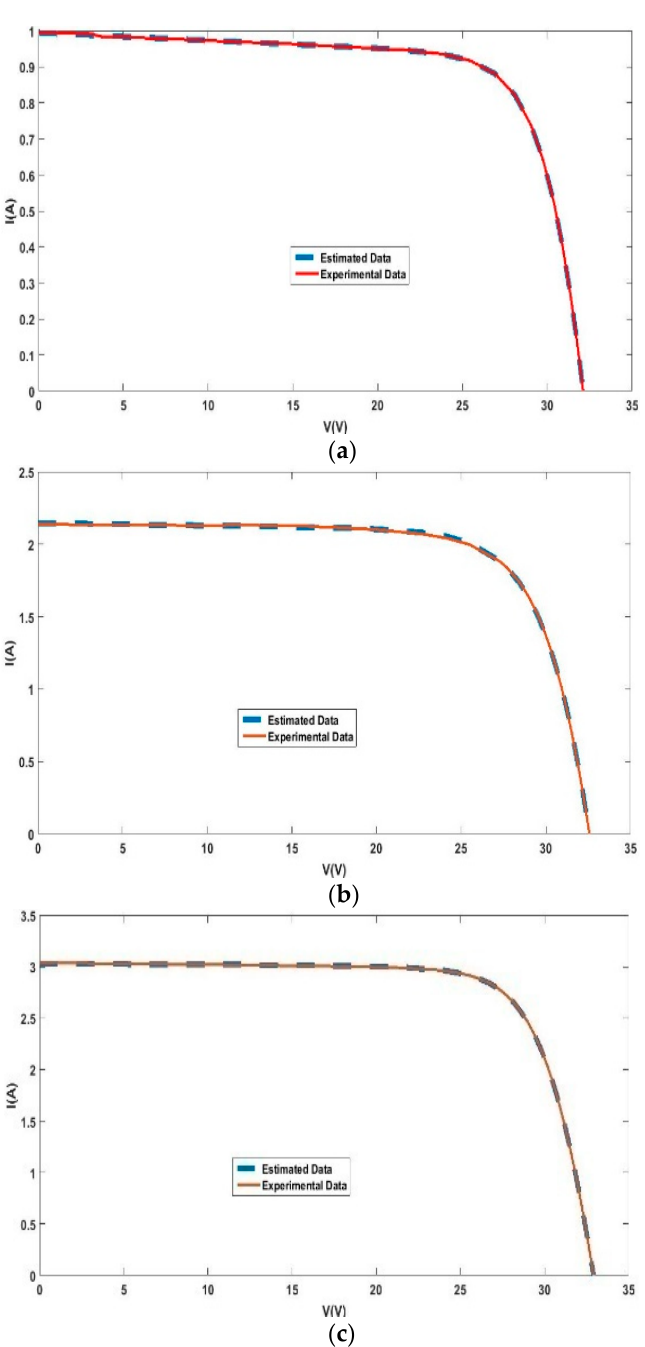
Figure 12. Estimated V-I versus experimental V-I at different environmental impacts using EHO for MTDM;( a ) at 109.2 W/m 2 and 310.32 K, ( b ) at 246.65 W/m 2 and 313.32 K, and ( c ) at 347.8 W/m 2 and 316.95 K. Table 6. The extracted parameters for MDDM and MTDM by EHO algorithms for 57 mm diameter commercial (R.T.C. France) silicon solar cell at 1000 W/m 2 and 306 K.